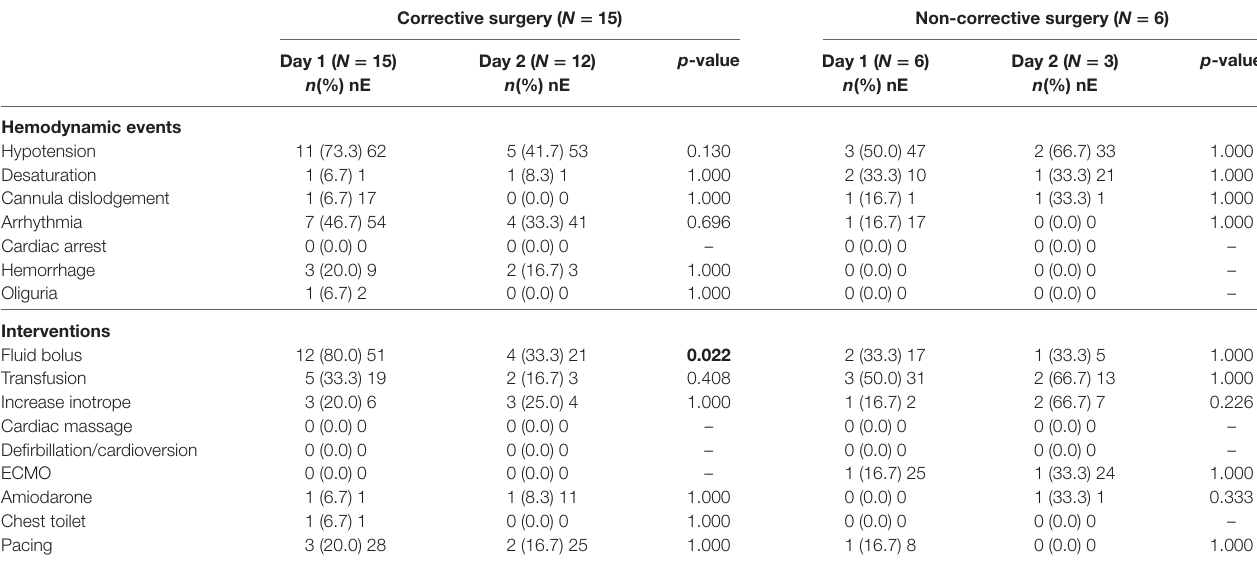
TaBle 4 | Significant postoperative hemodynamic events and interventions within first 2 postoperative